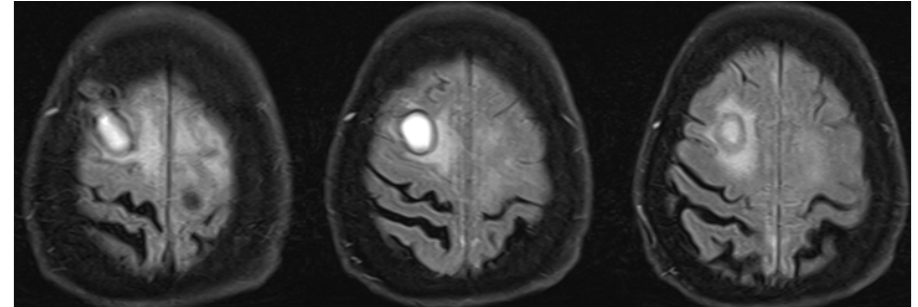
Figure 3. Right frontal lesion associated with rheumatoid arthritis. Right frontal lesion on T2 FLAIR MRI sequence that was differentiated between non-typical abscess and neoplastic changes (lymphoma, melanoma metastasis). Brain biopsy revealed necrotizing granulomatous inflamma- tion with pachymeningitis, findings compatible with CNS lesion due to rheumatoid arthritis. T2 FLAIR—T2-weighted-fluid-attenuated inversion recovery; MRI—magnetic resonance imaging; CNS—central nervous